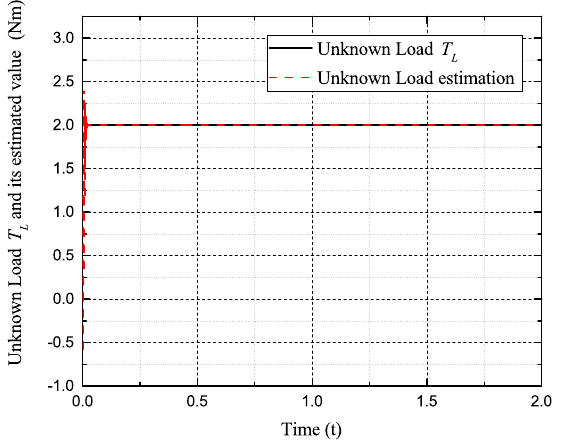
Figure 8. Unknown load disturbances T L a nd its estimated value ˆ T L .